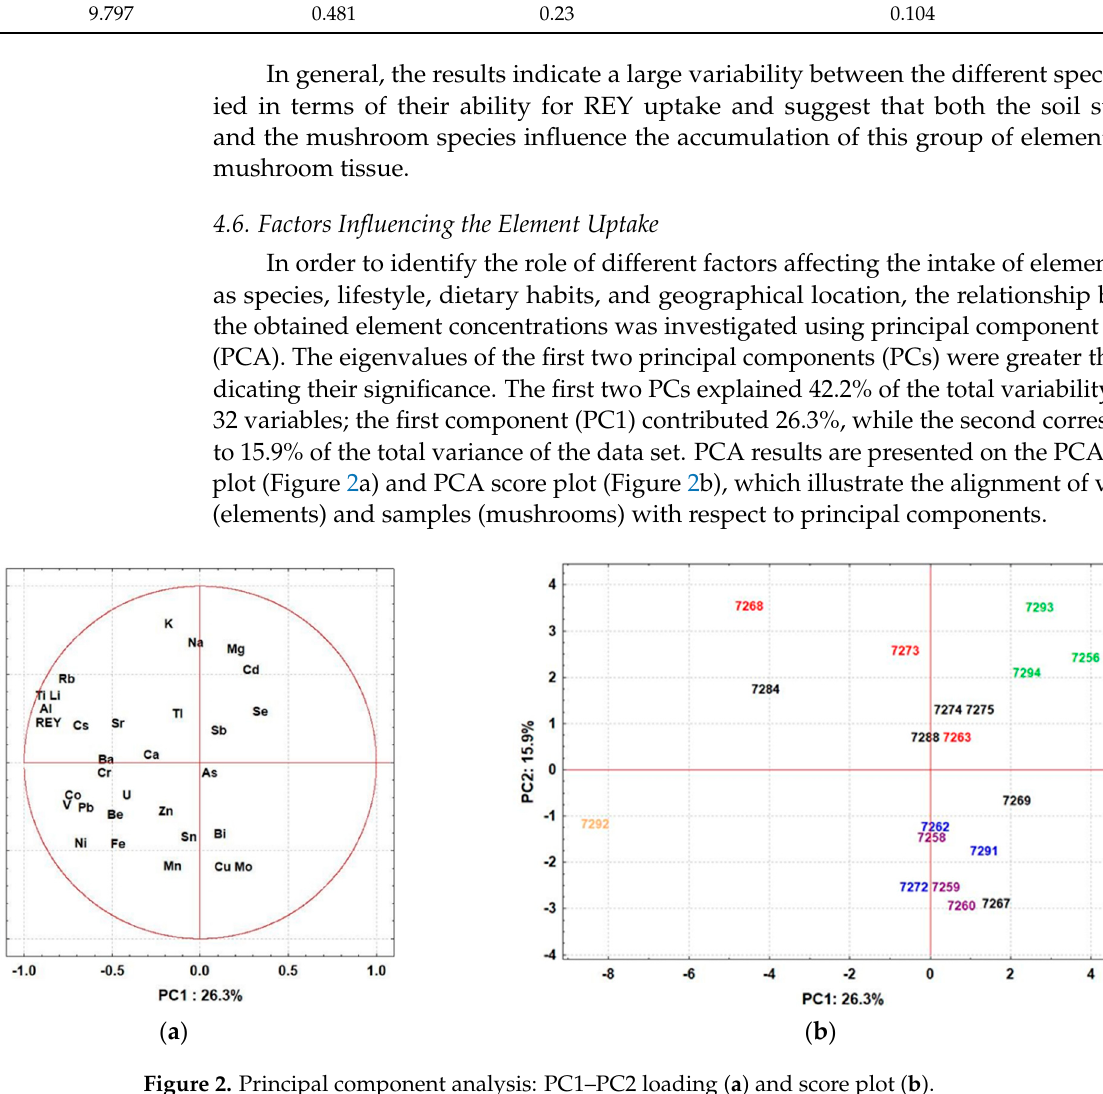
Figure 2. Principal component analysis: PC1–PC2 loading ( a ) and score plot ( b ).